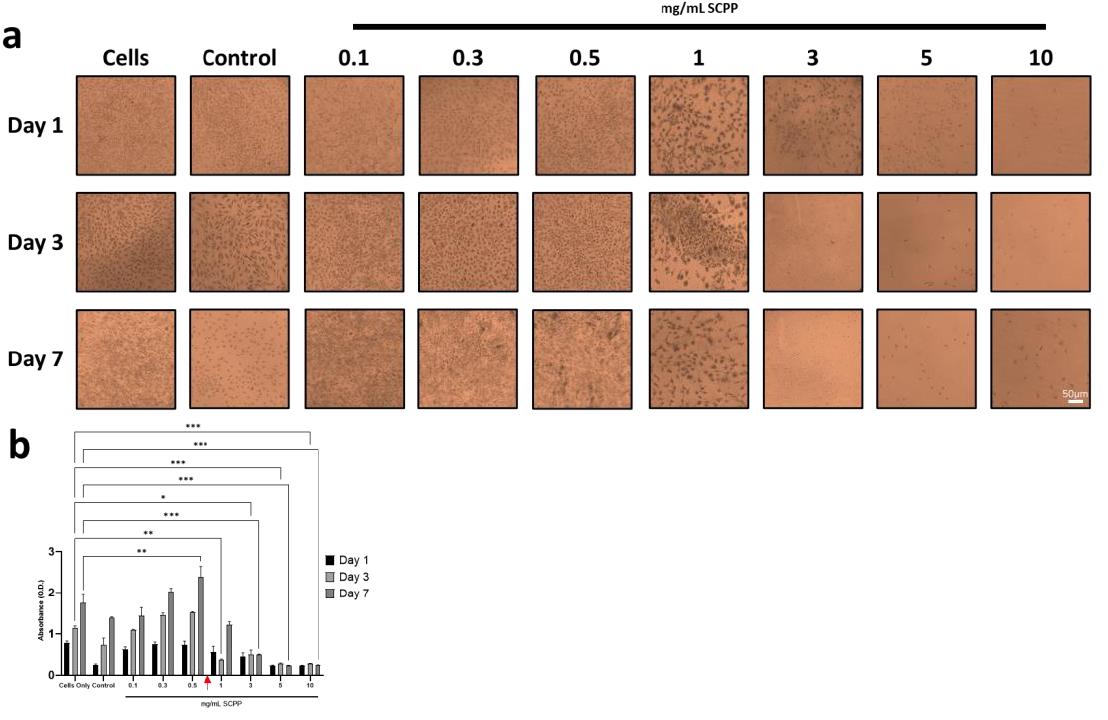
Figure 8. ( a ) LIVE/DEAD and DAPI staining of cell-laden scaffolds after printing, 3, and 7 days. Cells are present throughout the scaffold for up to 7 days. Dashed lines represent the borders of the scaffolds. ( b ) Quantification of LIVE/DEAD fluorescence over 7 days indicates cell growth. The greatest number of dead cells were present on day 0, after printing. * p ≤ 0.05, ** p ≤ 0.01, *** p ≤ 0.001.